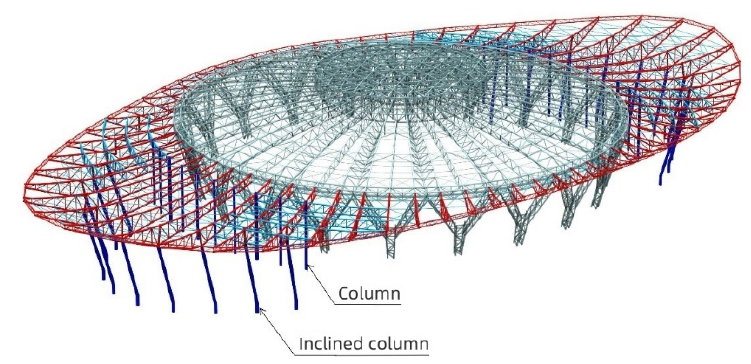
Figure 8. Schematic diagram of the steel structure in the auxiliary gymnasium.